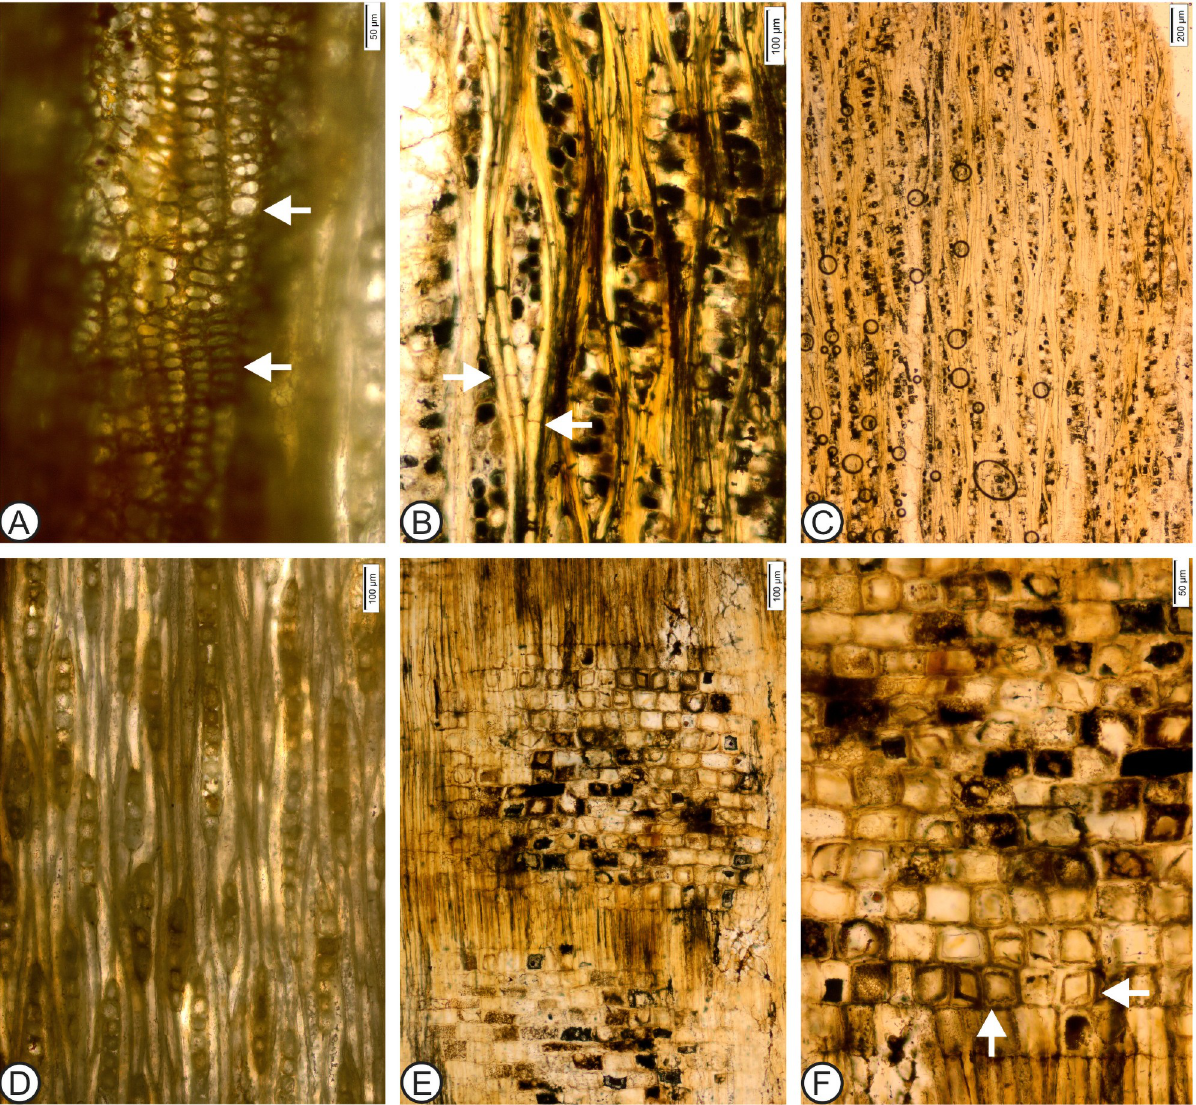
Fig 3. Anacardium gassonii Rodrı´guez-Reyes, Estrada-Ruiz et Terrazas sp. nov. B, C, E, F, MUPAN-STRI 44071; A, D, MUPAN-STRI 44051. (A) Vessel–ray parenchyma pits with much reduced borders, elongated and slightly in palisade (RLS). (B) Septate (arrows) and non-septate fibers (TLS). (C) Rays with 1–3 cells wide (TLS). (D) Rays mostly uniseriate (TLS). (E) Heterocellular ray (RLS). (F) Prismatic rhomboidal solitary crystals present in the procumbent and square ray cells (RLS).